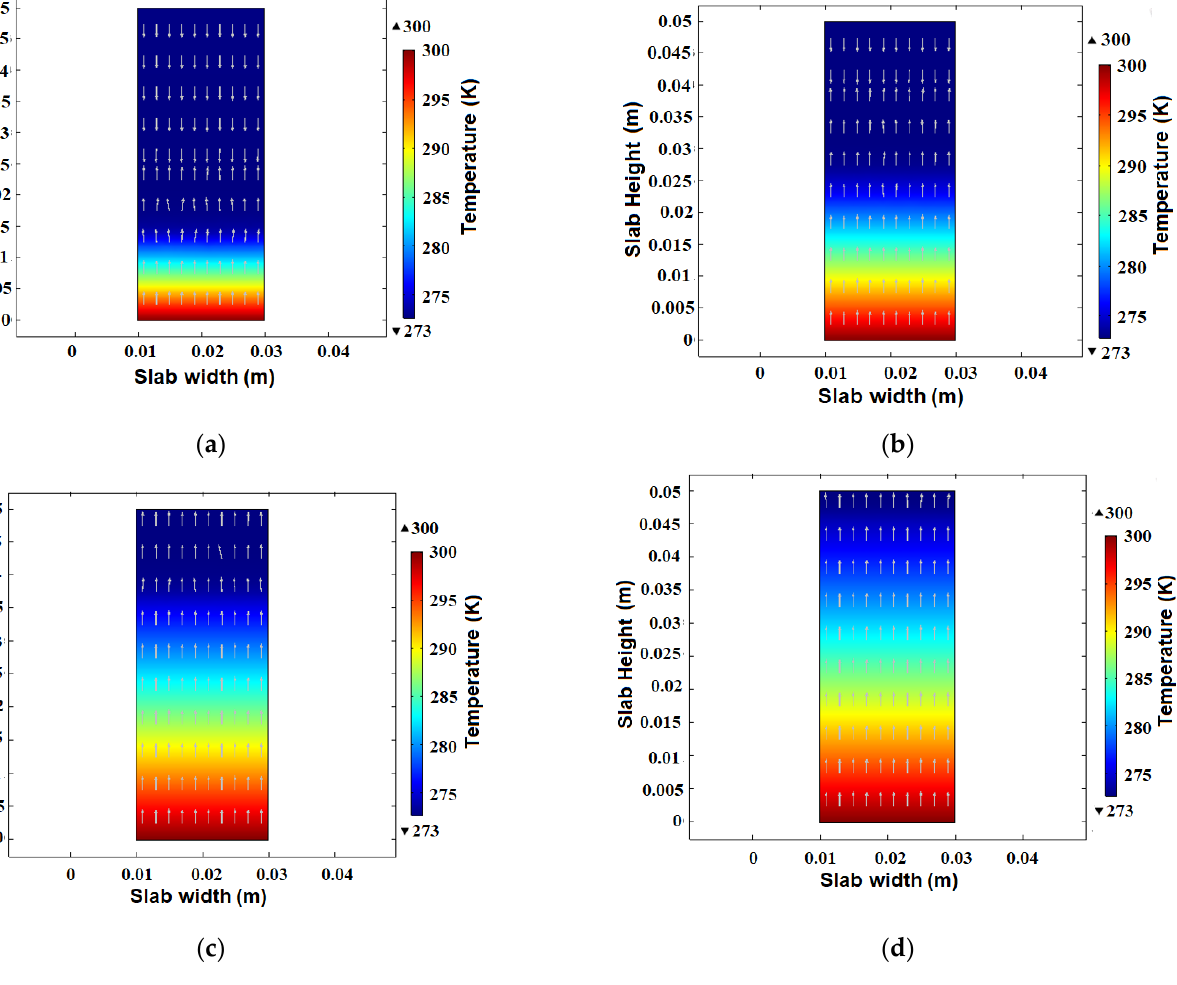
Figure 7. 2D temperature profile along the slab height after one ( a ), three ( b ), six ( c ), and nine ( d ) hours of heating.